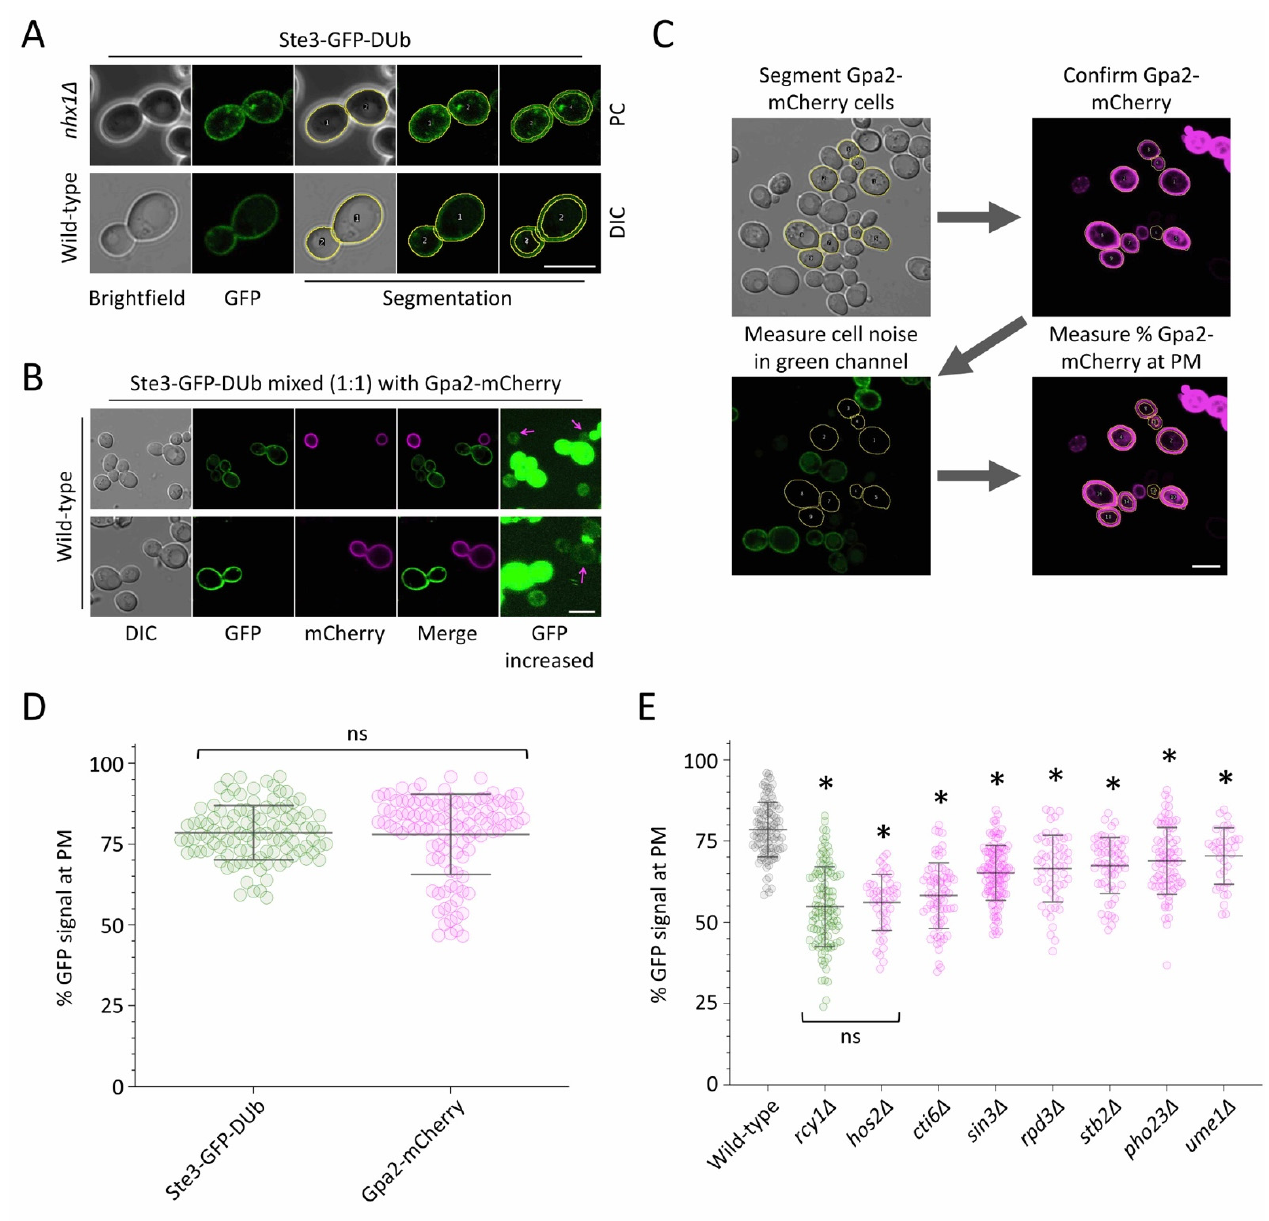
Figure 2. Quantification of Ste3-GFP-DUb recycling defects in Rpd3-complex mutants. ( A ) Cells expressing Ste3-GFP-DUb were grown to mid-log phase and imaged with Phase Contrast ( top ) or DIC ( bottom ) objectives. Segmentation with ROI shown overlaid on each fluorescence image. A second ROI that excludes the plasma membrane signal was created by morphological erosion. ( B , C ) Wild-type cells expressing Gpa2-mCherry from the CUP1 promoter, induced by the addition of 100 µ M copper chloride to the media, and wild-type cells expressing Ste3-GFP-DUb were mixed at a 1:1 ratio and imaged. mCherry-expressing cells were used to identify and segment the wild-type cells lacking GFP signal, allowing cellular background fluorescence in the green channel, observed at increased intensity ( right ), to be measured. ( D ) The surface levels of Ste3-GFP-DUb and Gpa2-mCherry were both calculated as a percentage. ( E ) The percentage of Ste3-GFP-DUb signal at the plasma membrane in wild-type cells (grey, n = 104) was compared with rcy1 ∆ mutants (green, n = 111) and various mutants (magenta) of the Rpd3 complex: hos2 ∆ ( n = 47), cti6 ∆ ( n = 73), sin3 ∆ ( n = 114), rpd3 ∆ ( n = 57), stb2 ∆ ( n = 61), pho23 ∆ ( n = 77), and ume1 ∆ ( n = 36). Student’s t -test comparisons between wild-type cells and each mutant are shown with asterisks (*) used to indicate significant difference ( p < 0.0001). Scale bar, 5 µm. We therefore refined parameters to define cells from DIC images and used this pro- tocol to estimate the background autofluorescence in the green channel capturing Ste3-